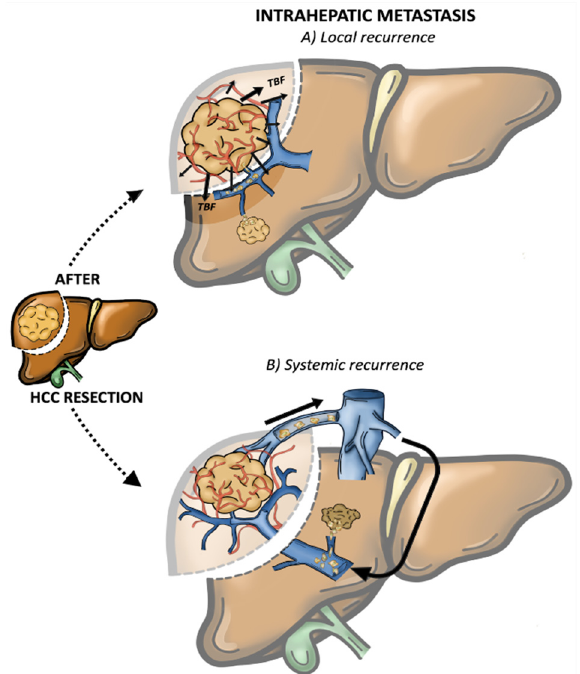
Figure 1. Intrahepatic metastasis (IM). ( A ) Local recurrence: the rHCC develops along the tumour blood flow (TBF) ( B ) Systemic recurrence: caused by circulating tumour cells (CTCs) in the rehoming of the remnant liver.